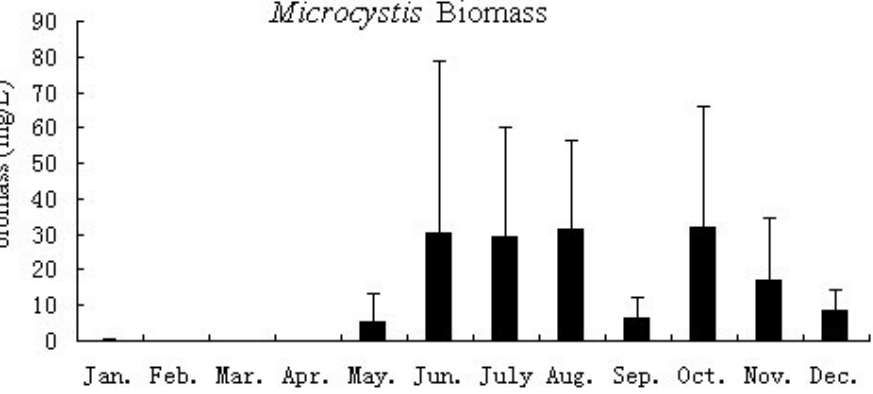
FIGURE 2. Seasonal variations of Microcystis biomass in Gonghu Bay 2008 (means ± standard deviation).